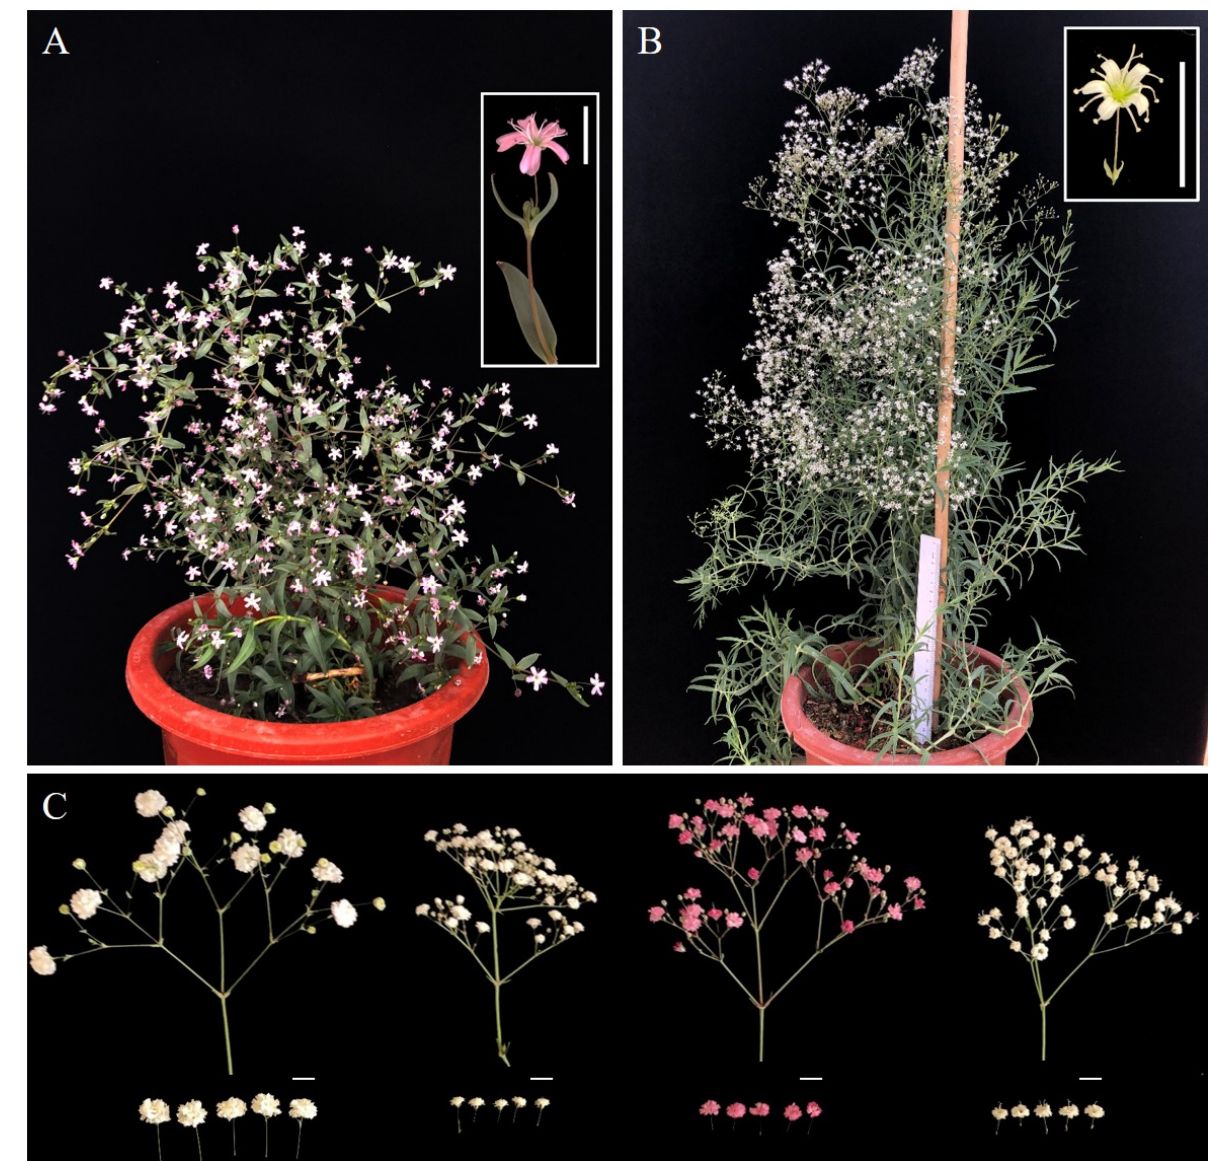
Figure 1. The phenotype of G. paniculata wild-type accessions and commercial cultivars used in this study. ( A ). The pink flower wild type of G. paniculata (WT-P). ( B ). The white flower wild type of G. paniculata (WT-W). ( C ). The flower phenotype of four commercial cultivars (‘YX1 ′ , ‘YX2 ′ , ‘YX3 ′ and ‘YX4 ′ , from left to right). Bar = 1 cm.